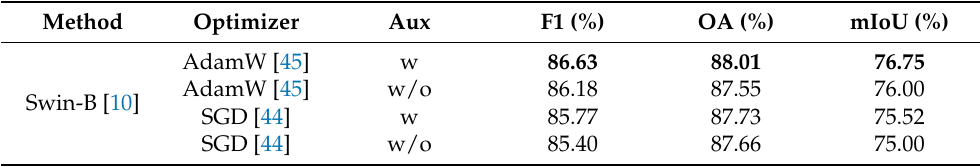
Table 4. The results of optimizers ablation study.